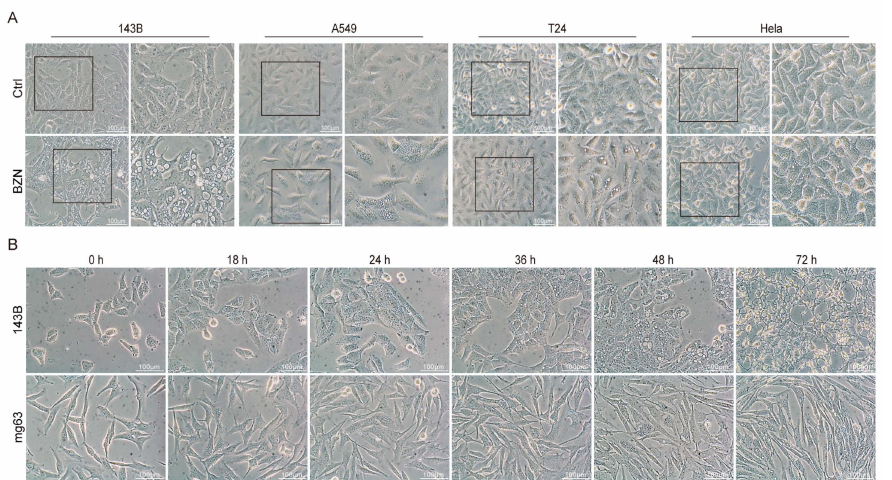
Figure 6. BZN induces cytoplasmic vacuolation in tumor cells. ( A ) The cell morphology of tumor cells (143B OS cells, A549 lung cancer cells, T24 bladder cancer cells, and Hela cervical cancer cells) treated with different concentrations of BZN (scale bars: 100 µ m). ( B ) Phase contrast images of OS cells were obtained at the indicated time points after BZN (6 µ M) treatment (scale bars: 100 µ